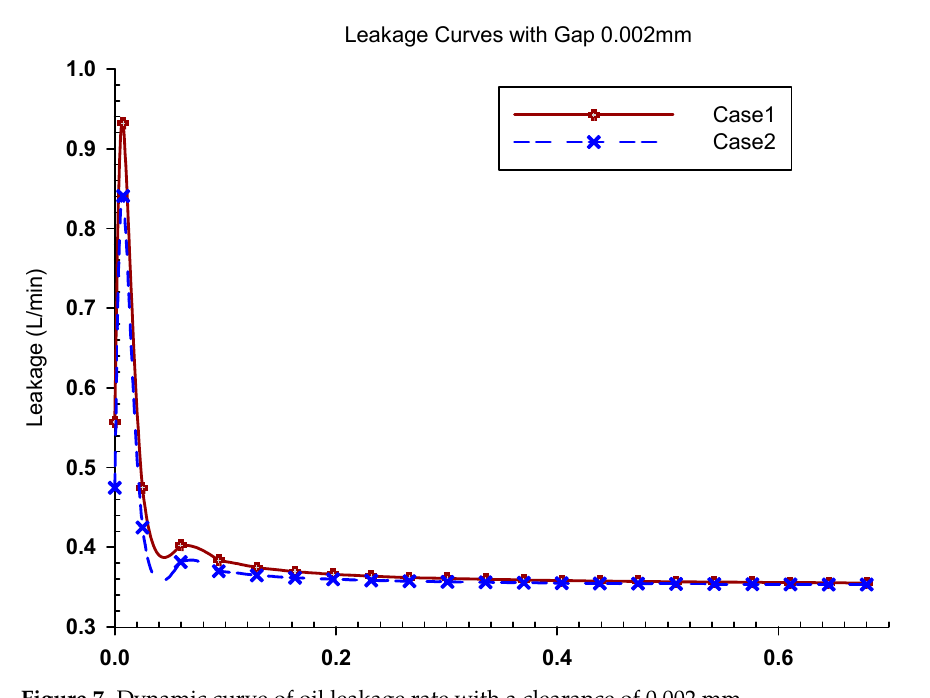
Figure 7. Dynamic curve of oil leakage rate with a clearance of 0.002 mm.